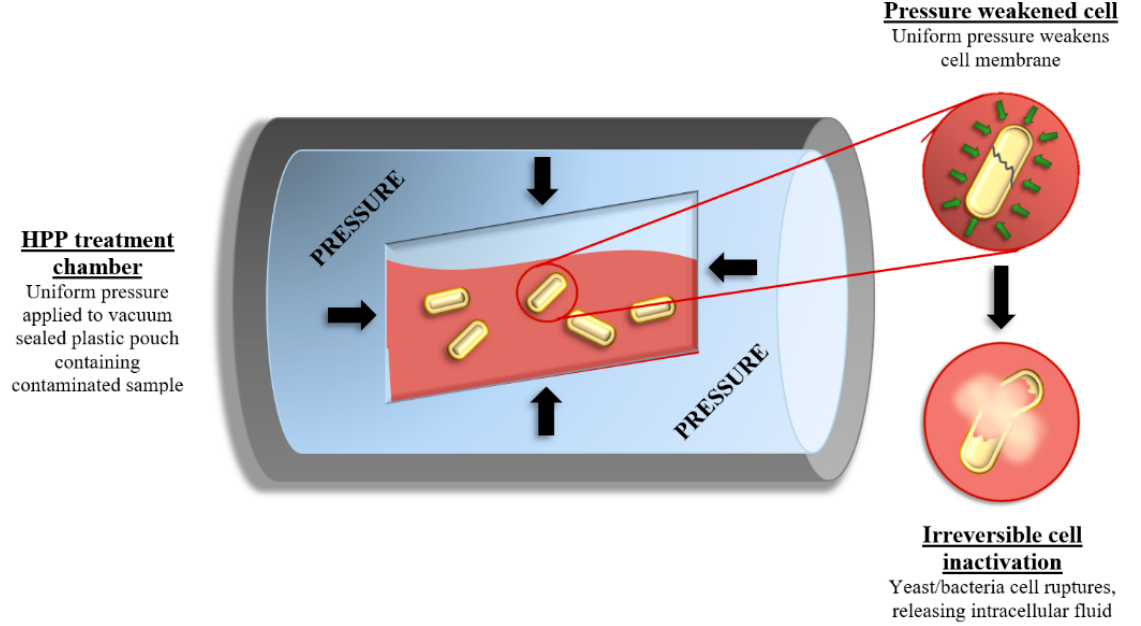
Figure 2. Diagram showing the high-pressure processing (HPP) inactivation of wine spoilage microorganisms.